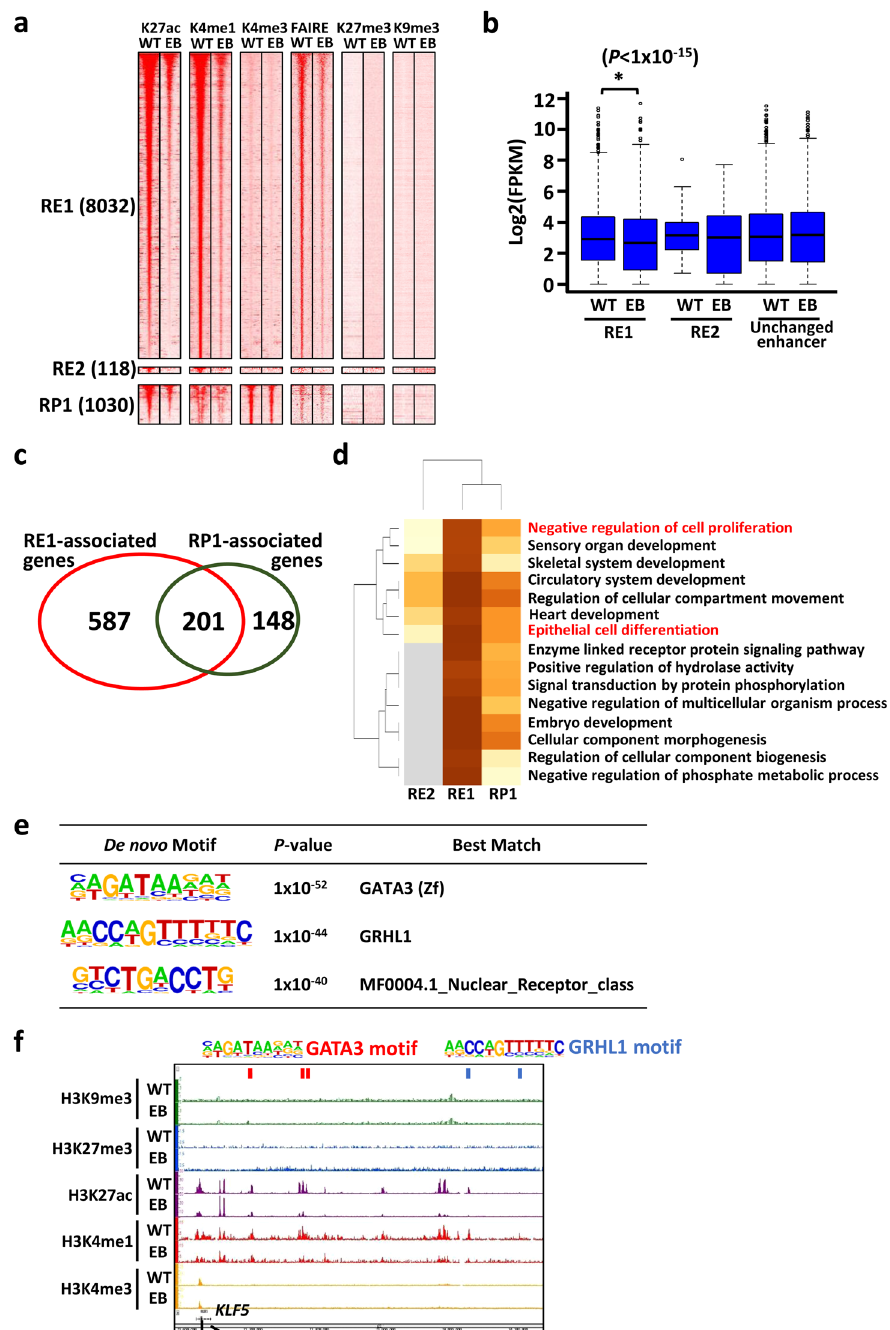
Figure 3. Epigenetic repression of enhancers and promoters in EBV-infected GC cells. WT , MKN7 without EBV infection. EB , EBV-infected MKN7 cells. ( a ) Heatmaps representing read densities of H3K27ac, H3K4me1, H3K4me3, FAIRE, H3K27me3, and H3K9me3 in ± 5-kb regions centred on repressed enhancers and promoters. RE1 and RE2 are subgroups of repressive enhancers in E2 and E7 respectively. RP1 is a subgroup of repressed promoters without repressive mark. ( b ) Expression level of genes nearest to each repressed enhancer and H3K27ac unchanged enhancers. Genes were significantly downregulated in EBV-infected MKN7 cells in RE1 ( P < 1 × 10 − 15 : calculated by paired t -test). ( c ) Overlap of RE1-associated genes ( red ) and RP1-associated genes ( green ). This Venn diagram showed that as many as 587 genes were downregulated with enhancer repression without a decrease of H3K27ac at the promoter. ( d ) GO enrichment analysis of genes with enhancer or promoter repression. Colour scale represents binomial P -values (in -log 10 scale). Genes associated with “Negative regulation of cell proliferation” and “Epithelial cell differentiation” were preferentially regulated by both promoter and enhancer repression. ( e ) Enriched known motif at open chromatin regions detected by FAIRE-seq overlapped with RE1. ( f ) Histone modification and position of enriched motifs around the representative repressed gene, KLF5